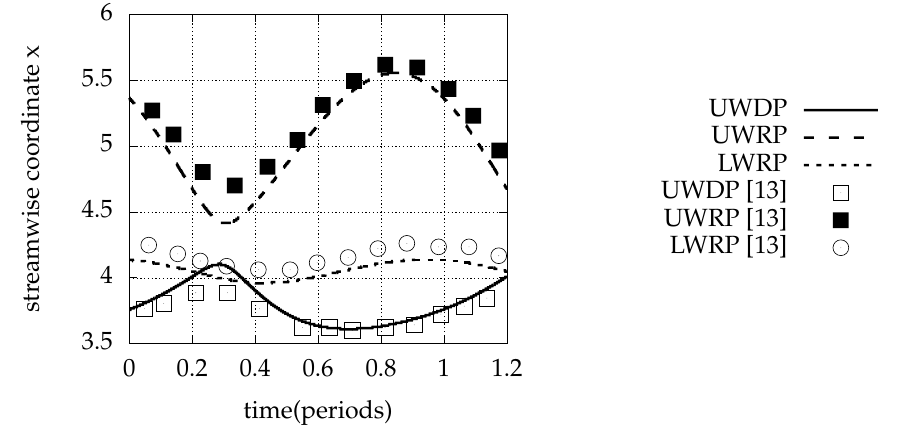
Figure 11. Upper wall detachment position (UWDP) and upper and lower wall reattachment positions (UWRP, LWRP) for unsteady periodic inflow with α = 0.05, ω = 0.05, and Re = 400 without control ( A = 0). Comparison with results of Mateescu et al. [13] is